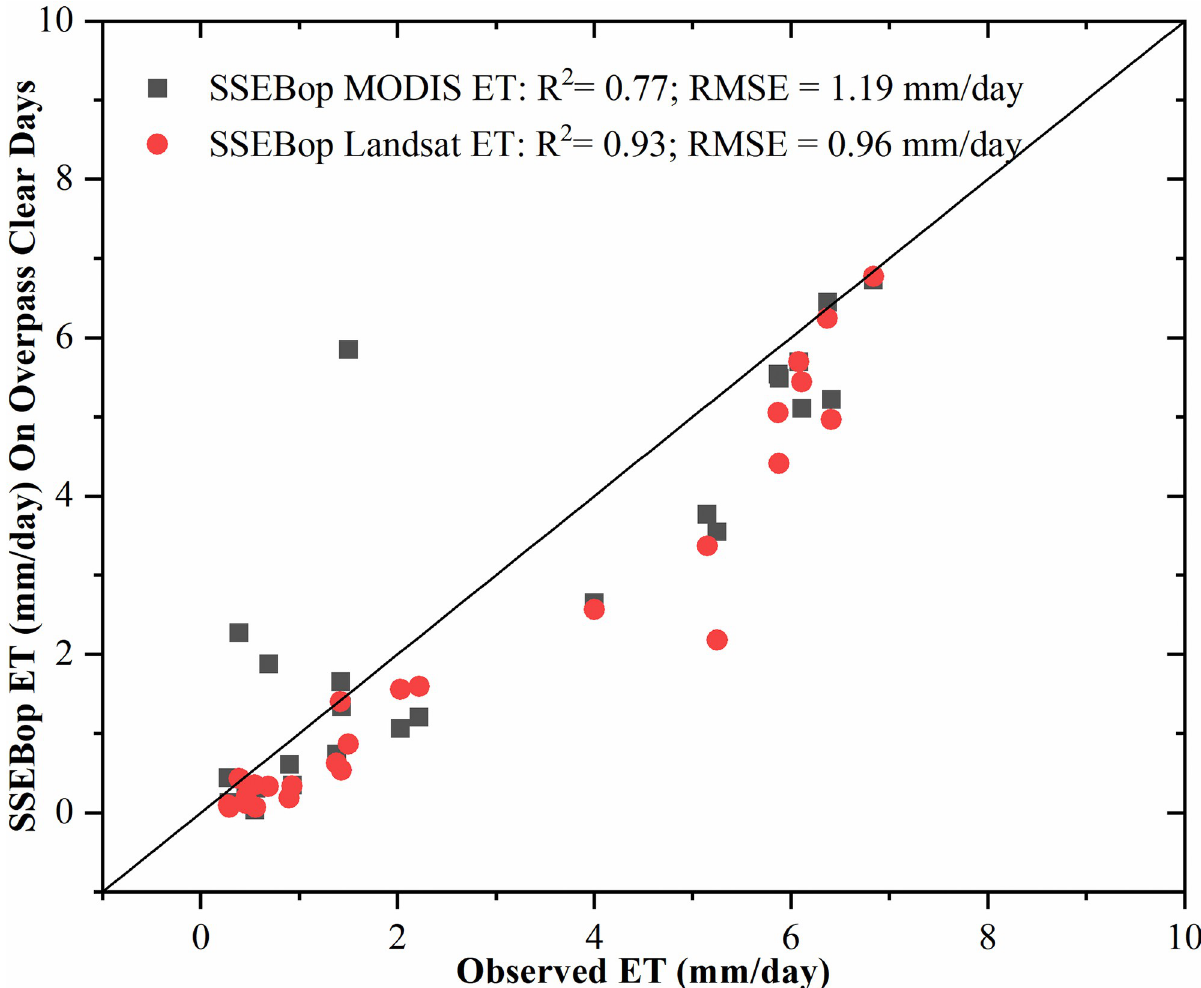
Fig 4. The validation of the estimated SSEBop ET using MODIS and Landsat data on the 26 Landsat 8 overpass clear sky days from 2013 to 2015.